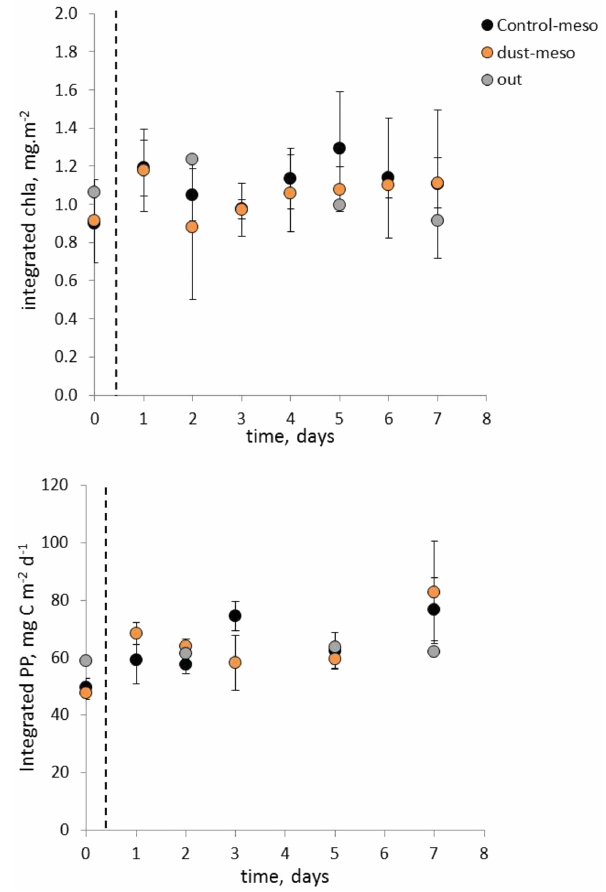
Figure 3. Mean integrated chlorophyll a (Chl a) in mgm − 2 (top panel) and mean integrated primary production (PP) in mgCm − 2 d − 1 (bottom panel) over mesocosms during the DUNE- 1-Q experiment in the Control-meso (black dot), Dust-meso (orange dot) and out (grey dot). The dotted line represents the time of the dust seeding. Data in the Control-meso and Dust-meso represent the average and standard deviations of the three replicate